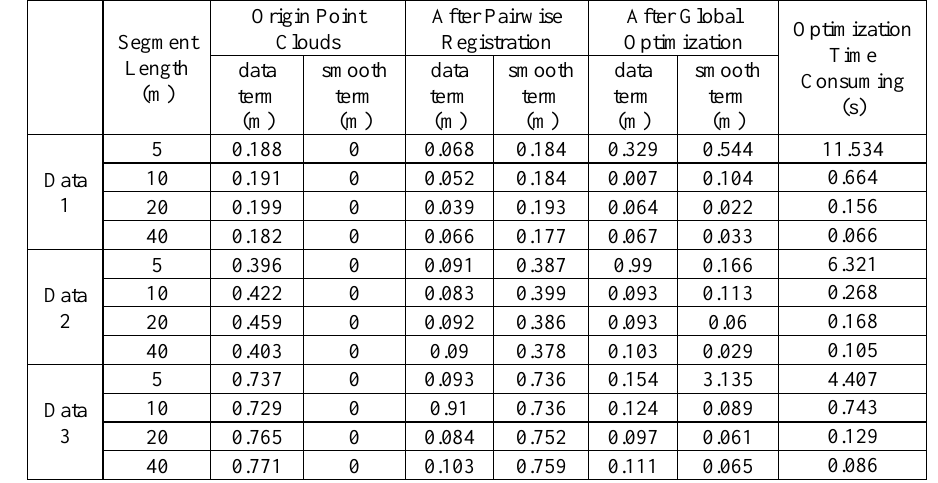
Table 2. Position inconsistency correction result of MLS point